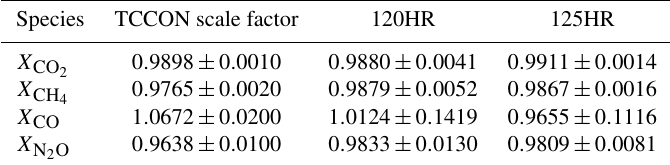
Table 4. Comparison of airborne calibration scale factors, derived from Lauder flights, with TCCON network-wide values. Species